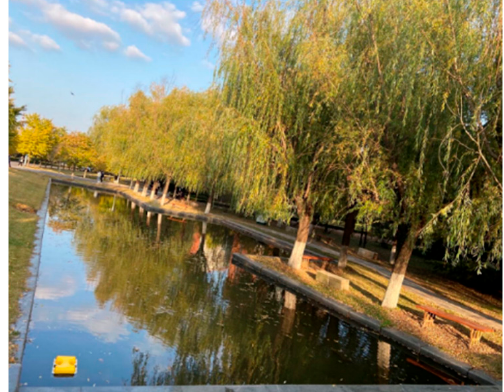
Figure 20. The desired path in a real man-made river.